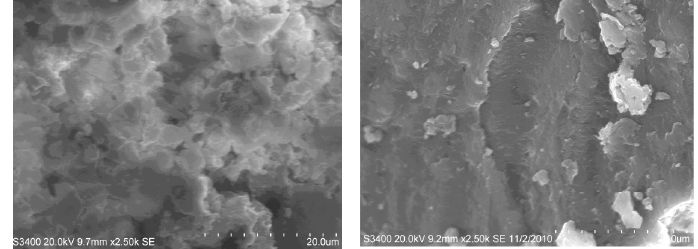
Figure 3. (a) TBHD before UV irradiation (b) TBHD after UV